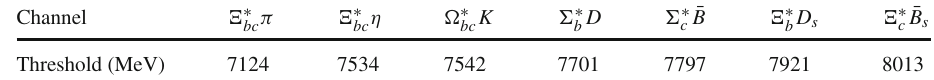
Table 30 D ij coefficients for sector J P = 3 / 2 − (S)